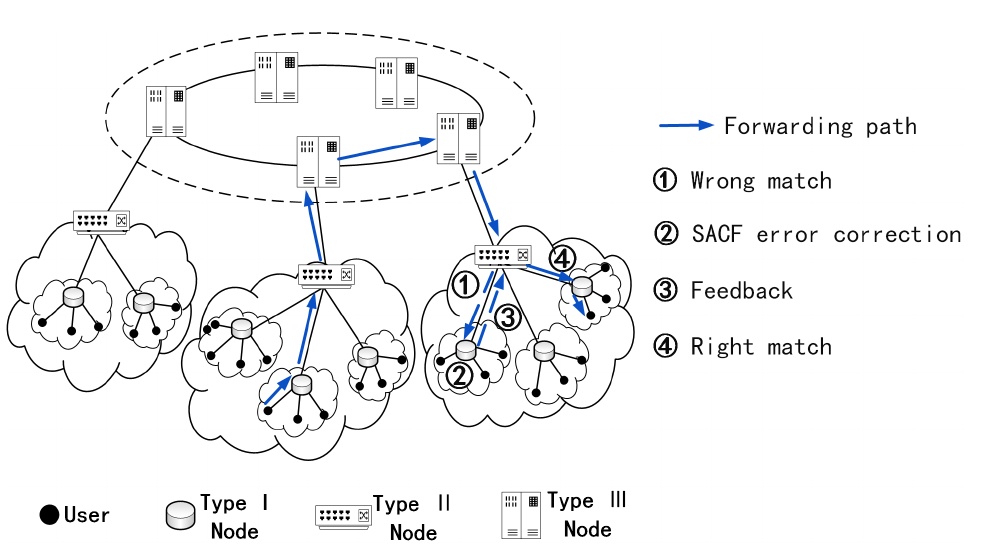
Figure 5. Error correction feedback